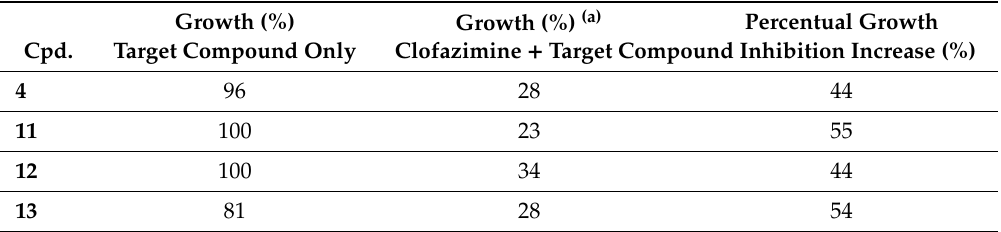
Table 2. Mtb cell e ff ects of selected target compounds 4 and 11 – 13 under clofazimine co-application. Growth (%) Growth (%) (a) Percentual Growth Cpd. Target Compound